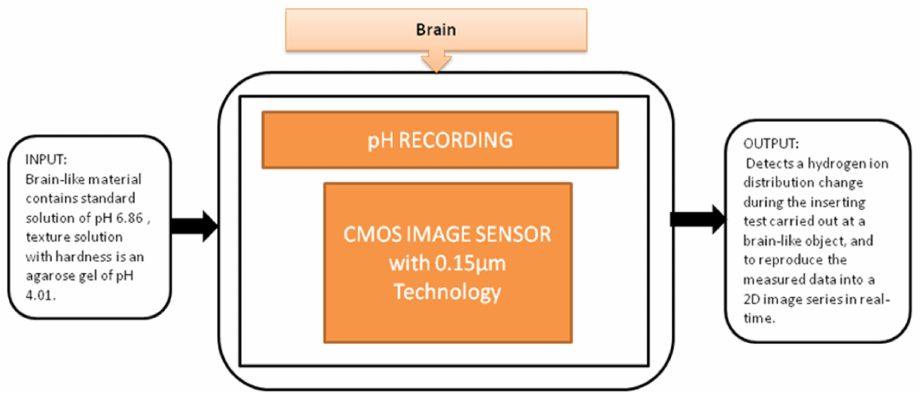
Figure 22. pH recording using CMOS image